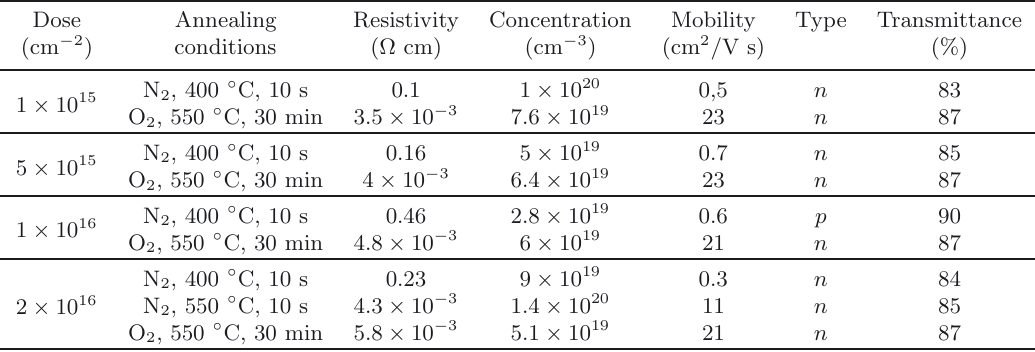
are preferentially c -axis oriented. The post-implantation annealing reduced the structure damage. The higher inte- grated intensity of a (002) diffraction line suggests more textured structure after annealing in O 2 for 30 min than after annealing in N 2 for 10 s. The peaks’ positions are shifted toward higher 2 θ angles and their values for the corresponding diffraction lines are as follow: 31 . 79 ◦ /(100), 34 . 47 ◦ /(002), and 36 . 27 ◦ /(101). A shift to higher 2 θ angles corresponds to the reduction of the interplanar spacing d most likely due to Ga atoms that occupy the Zn lattice site. This assumption is supported from the rise in the